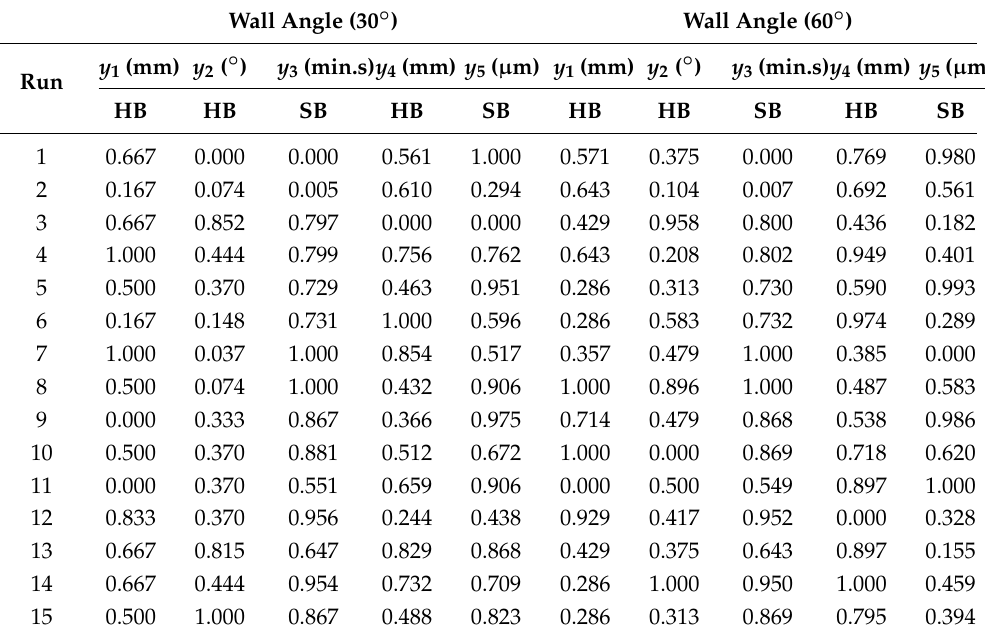
Table 5. Grey relational generation values.